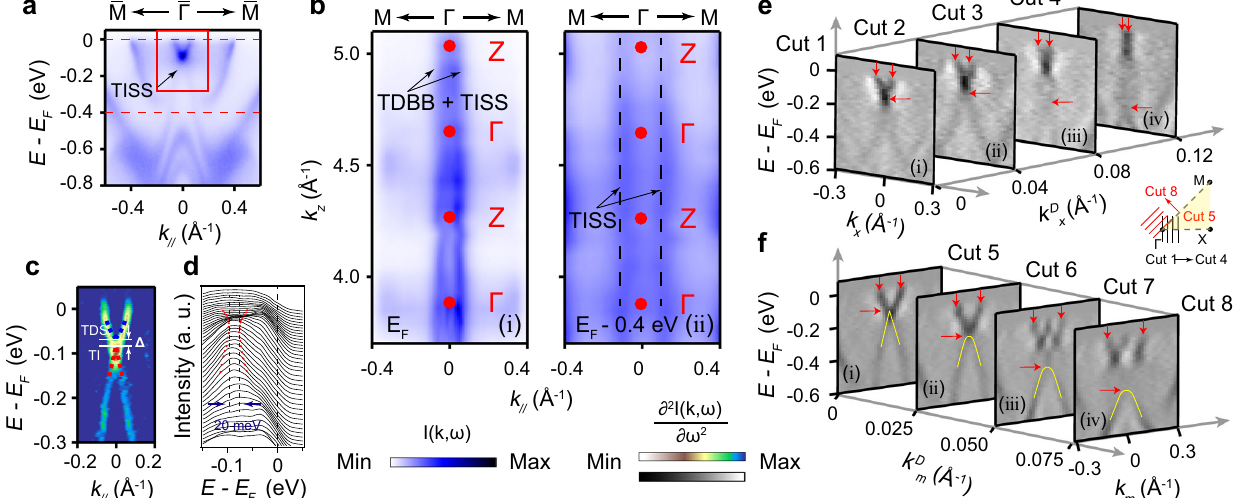
Fig. 3 The topological surface states. a Intensity plot along Γ - M direction with s -polarized 52 eV photons. The sharp surface states (TISS) near Γ point are dominated. b Intensity plot of k Γ - M direction with s -polarized photons at E i ) and E ii ) , z dependent ARPES data along F ( F - 0.4 eV ( which indicate the k z dispersion of TDBB hybridizating with TISS and TISS, respectively. c , d Second derivative plot and EDCs of the region in = 0, 0.04, 0.08, 0.12 Å − 1 and the red box in ( a ). A gap between two Dirac points is marked. e , f Second derivative intensity plots taken at k D x = 0, 0.025, 0.05, 0.075 Å − 1 , respectively. Cuts 1 to 8 are k D m